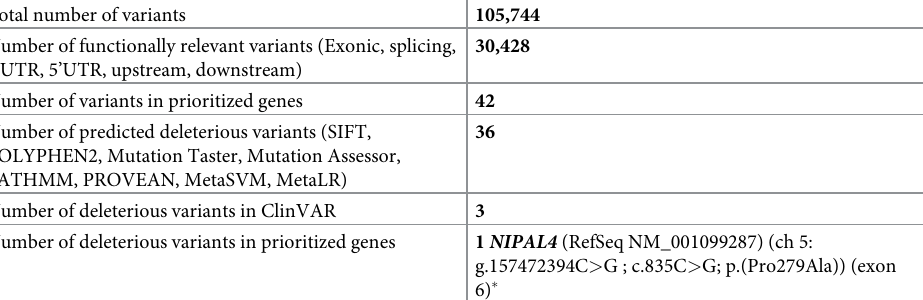
Table 2. Number of variants at the different stages of filtration in the exome sequencing data of the proband